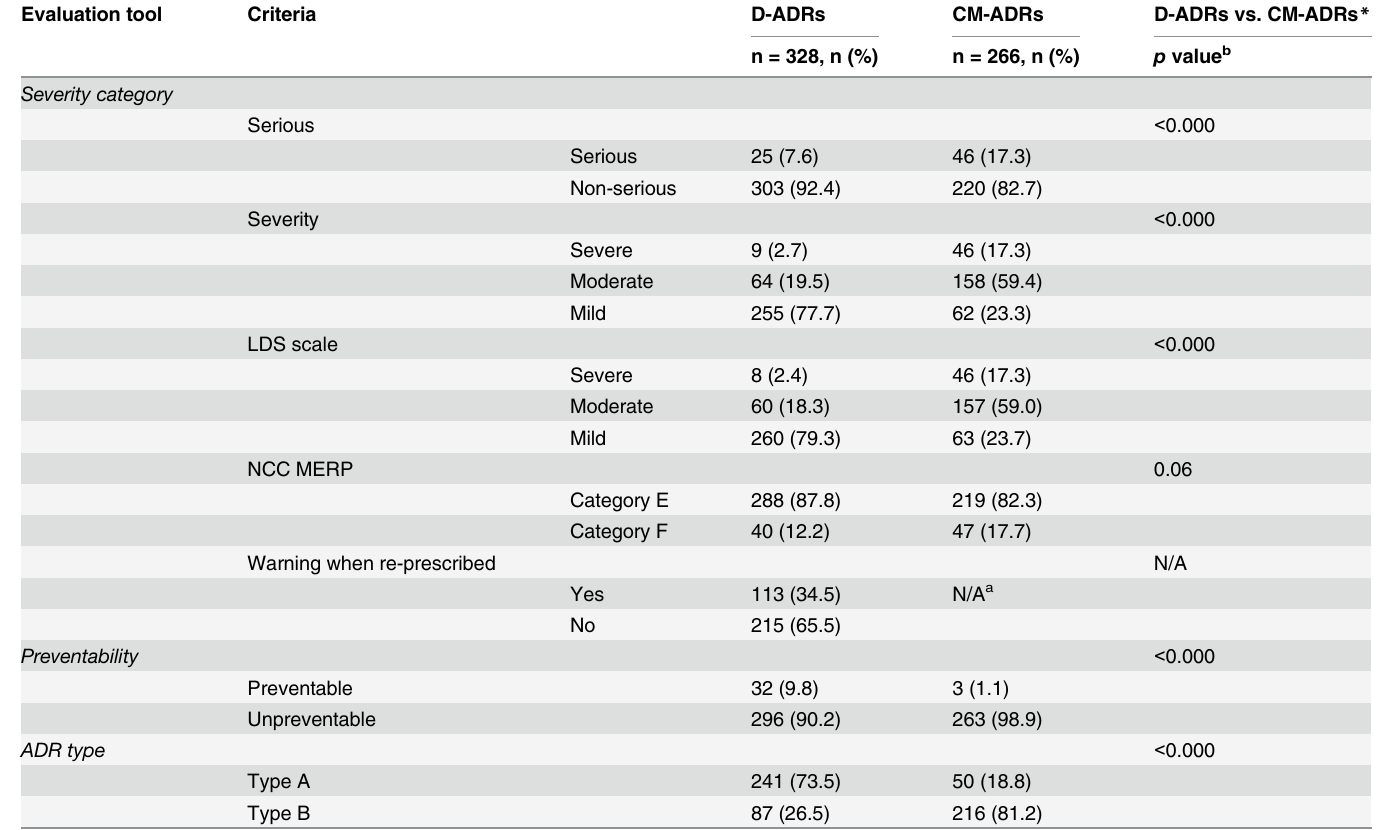
Table 5. Adverse drug reaction (ADR)